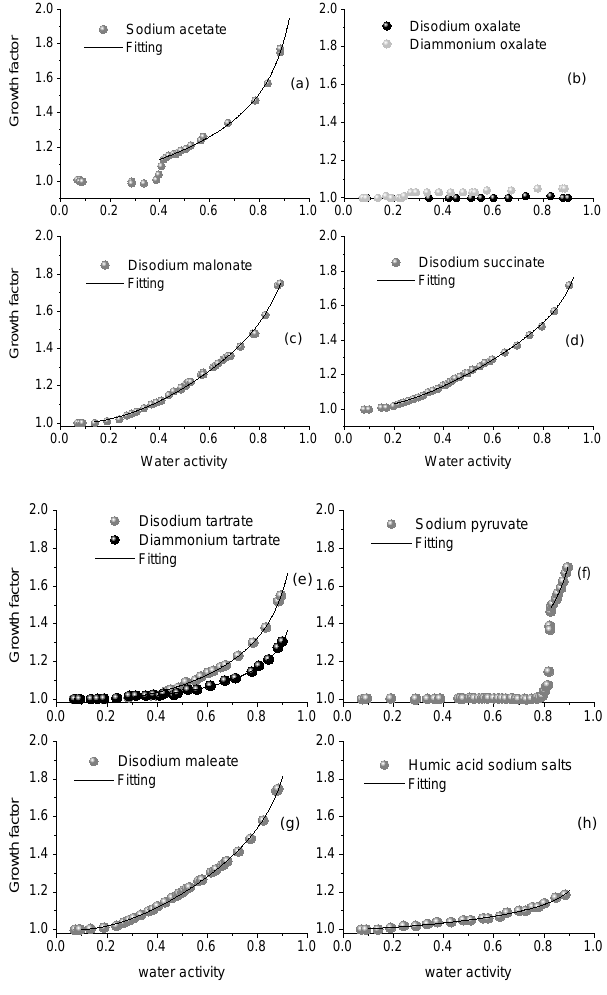
Fig. 1. Hygroscopic growth factors of organic salts as a function of water